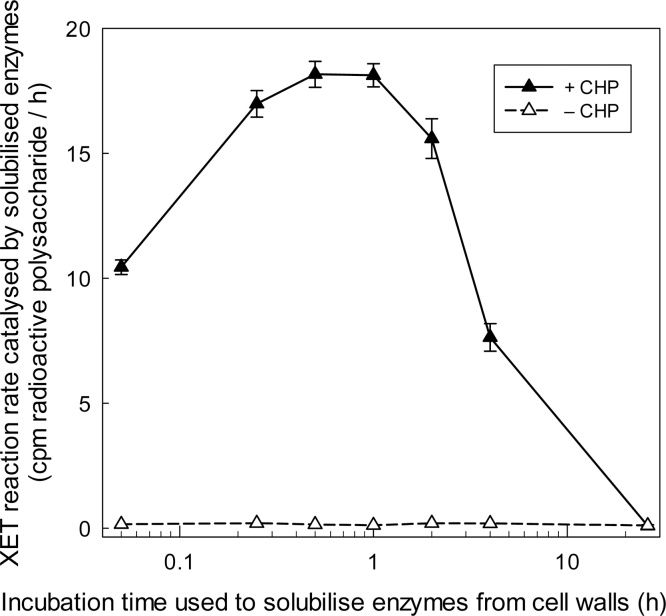
CHP transiently solubilises XTHs from a crude cell-wall preparation of suspension-cultured Arabidopsis cells. Tissue from 3-day Arabidopsis cell suspension-cultures was frozen, thawed, copiously water-washed, dispensed into PL-blocked 1.5-ml polypropylene tubes, and gently shaken in buffer [150 mM MES (Na+, pH 5.5) containing 100 μM non-radioactive XXXGol and 0.3% tamarind xyloglucan] with and without CHP (1.5 mg/ml). At intervals (shown on x-axis), 70 μl of supernatant was transferred into a PL-blocked PCR tube, frozen until all samples were ready, then thawed; 1 kBq [3H]XXXGol was added and incubation was continued at 20 °C. At 0, 2, 4 and 24 h, a 15-μl sample was assayed for [3H]polysaccharide product. The reaction in each case was approximately linear, and the gradient (linear regression ± its SE; df = 2) was calculated (plotted on y-axis). In this experiment, a yield of 100 cpm of 3H-polysaccharide indicates 2.3 pmol XXXGol incorporated.